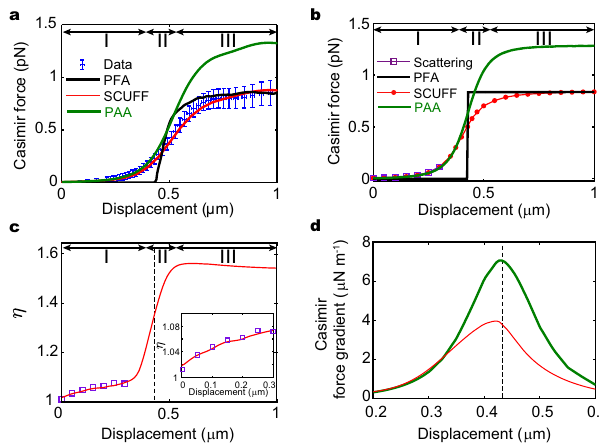
Fig. 5 Force calculated with the pairwise additive approximation. Comparison of the Casimir force calculated by SCUFF-EM (red), PAA (green), measurement (blue), and PFA (black) for one unit cell of the silicon grating that is a digitized from the top view of the experimental device and b perfectly rectangular. The measured data and error bars are the same as Fig. 4. c Ratio η of the forces calculated by PAA to scattering theory (purple) and SCUFF-EM (red) for perfectly rectangular gratings. The black dashed line marks where interpenetration occurs. Inset: Zoom-in for displacement between 0 nm and 300 nm. d The gradient of the Casimir force calculated using PAA (green) is symmetric about the dashed line that marks the distance at which interpenetration takes place for silicon gratings that are perfectly rectangular. The actual Casimir force gradient peak (red) is at a slightly smaller displacement and is asymmetric. The optical properties of silicon are used for all calculations (see